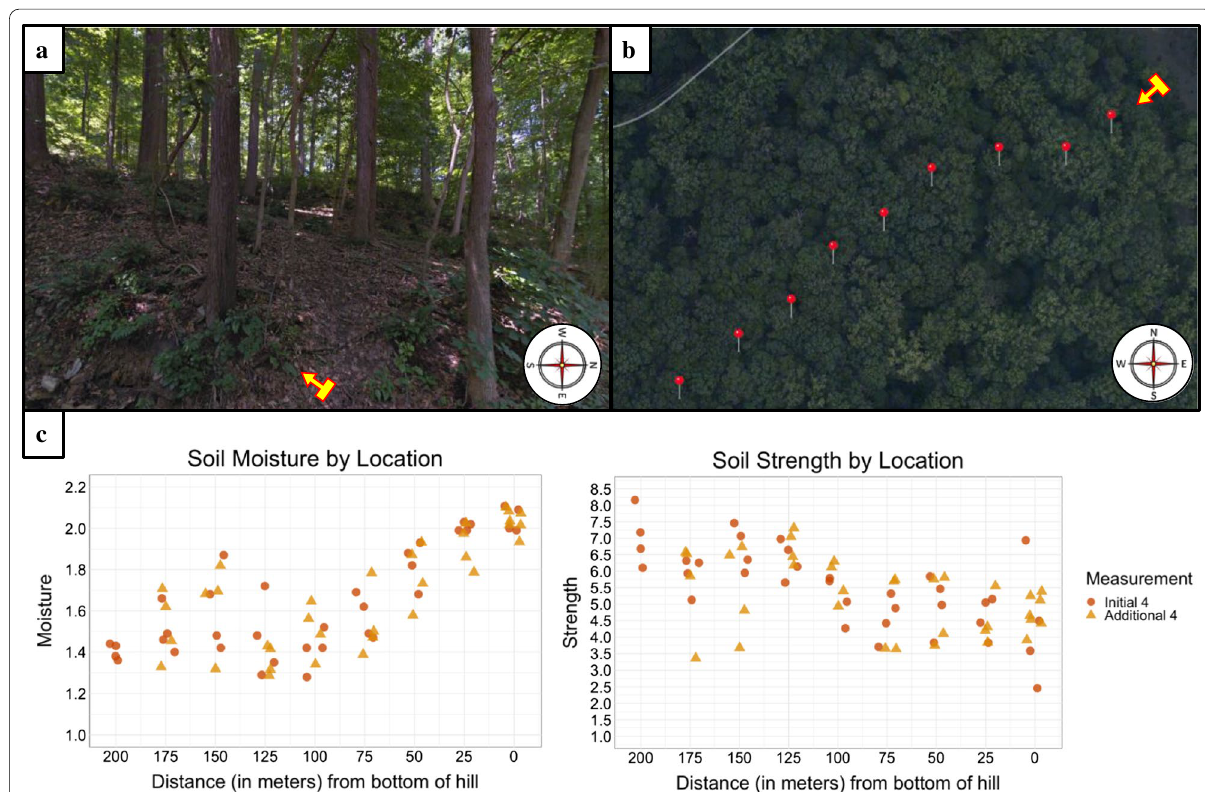
Fig. 1 a Field site in Wissahickon Valley Park where expert geoscientist case study participant received surface-soil intrusion strength data and soil moisture data in situ. The yellow arrow, located at the bottom of the hill, points uphill to the SW along the hill transect where data was collected. b Aerial view of the hill transect, with the yellow arrow in the same position and pointing in the same direction as in A. The expert geoscientist had an initial strategy of taking four measurements each at nine evenly spaced locations. c After the expert saw the variability in the first four measurements (represented by red circles) at each location in situ, he opted to adjust his initial strategy and take four additional